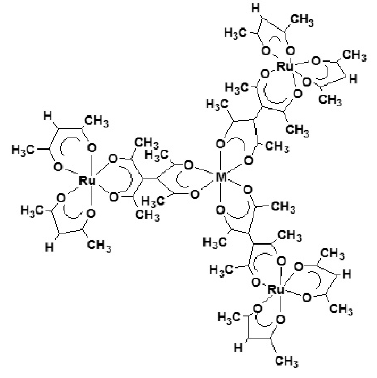
Chart 3. Illustrating a star-burst tetranuclear complexes with inert three peripheral and labile central core. Hetero-chiral ( left ) and home-chiral connections ( right ).